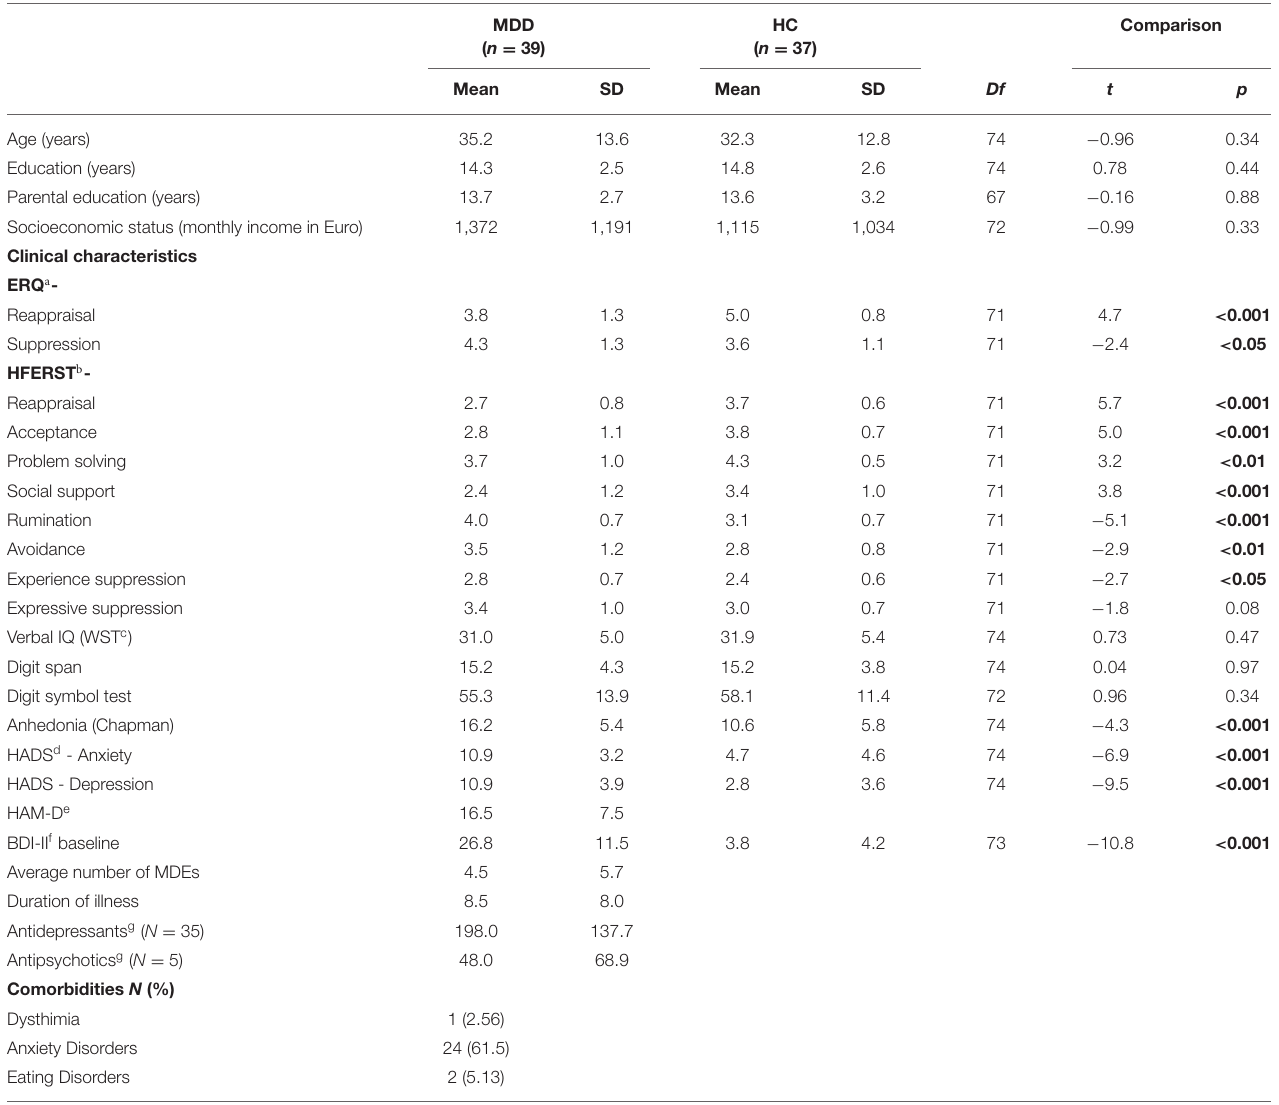
TABLE 1 | Demographic and clinical